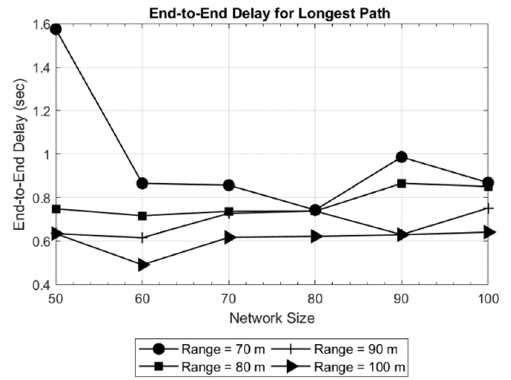
Figure 5. Average delay in network of 200 × 200 × 200 m.